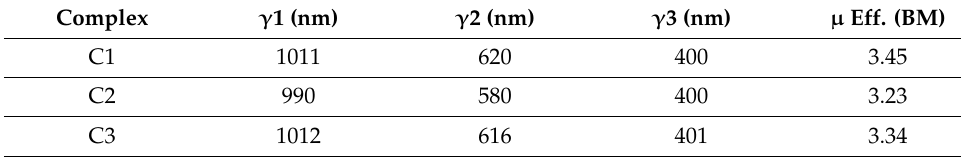
Table 3. Electronic and magnetic moment studies of complexes.